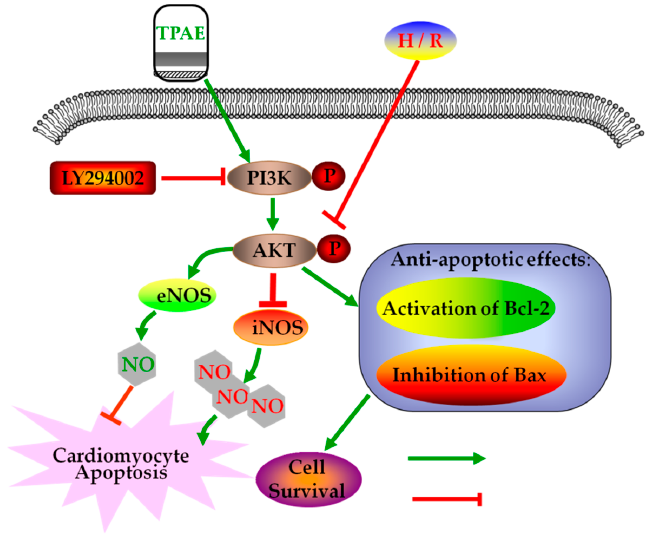
Figure 6. Schematic diagram of the mechanism by which TPAE attenuates H/R induced cardiomyocyte apoptosis by regulating NO production via activating the PI3K/Akt signaling